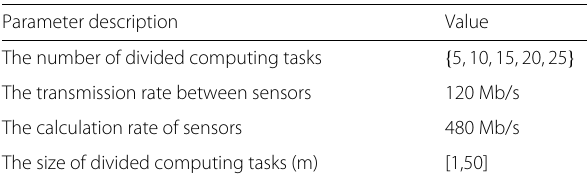
Table 2 Parameter settings